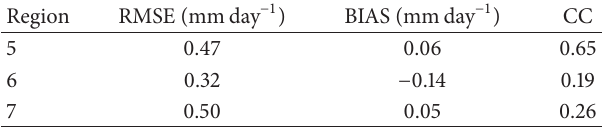
Table 5: Area averaged root mean square error (RMSE) and bias and spatial correlation coefficient (CC) for the annual mean pre- cipitation (mmday − 1 ) anomalies for HCSA poleward expansion cases over the last three regions of Figure 5 in the period 1996–2011.